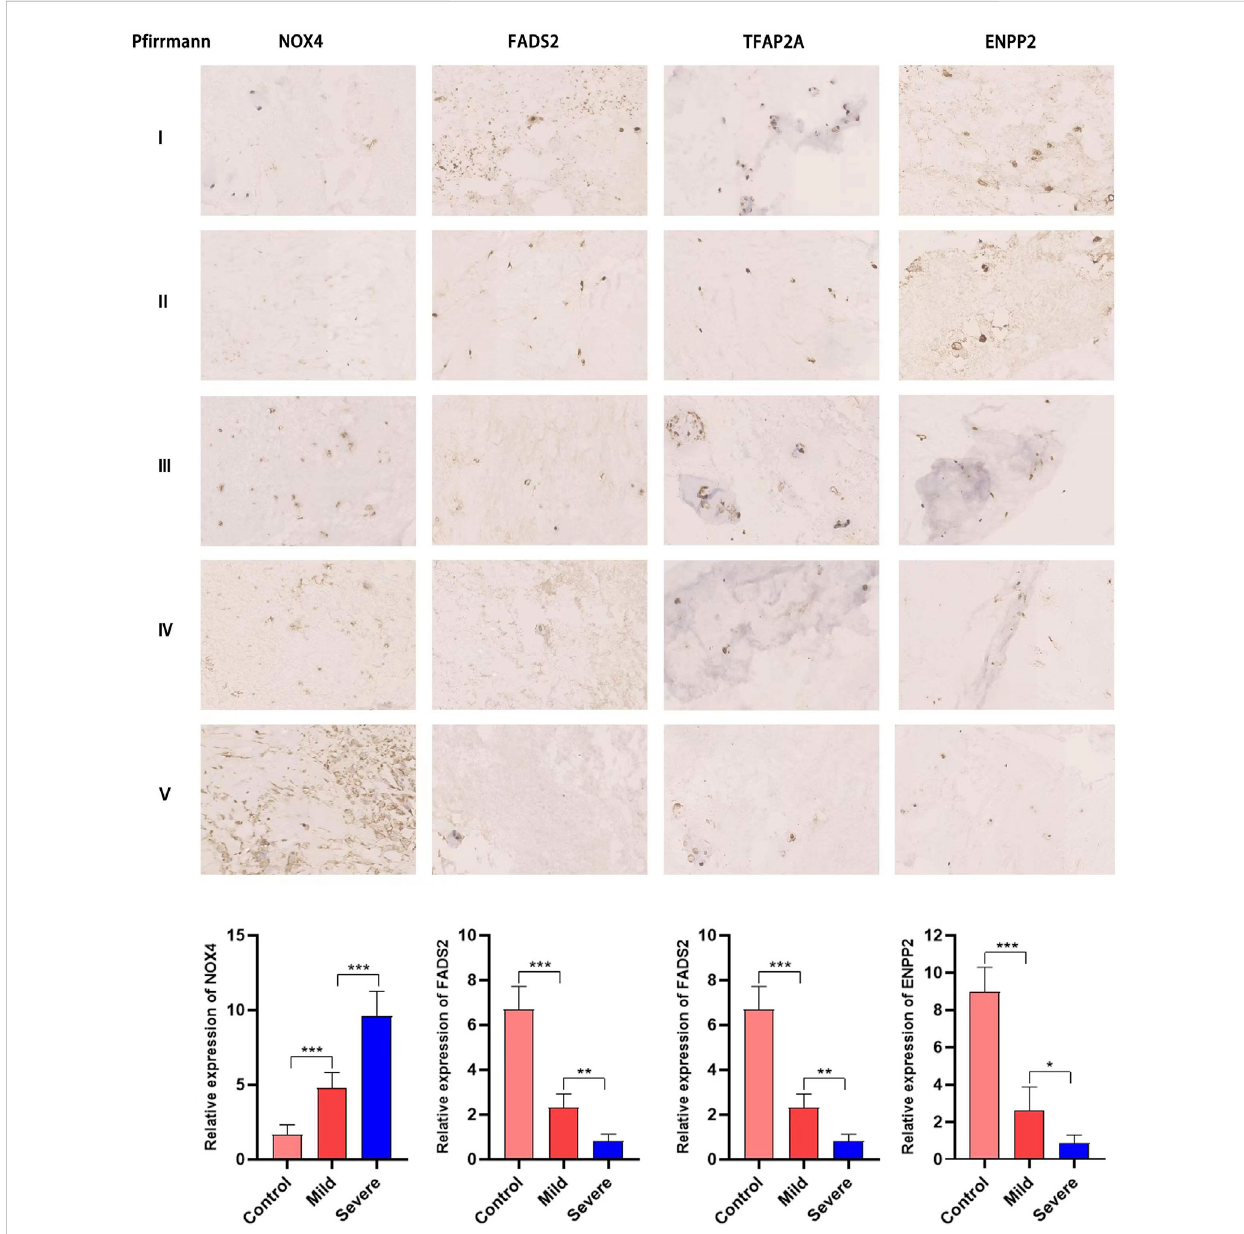
FIGURE 10 Immunohistochemical staining has proved that NOX4, FADS2, TFAP2A, ENPP2 expression in NP tissues of different degeneration grades. The expression ofNOX4 increases withtheincrease ofdegenerationgrade, whiletheexpressionofFADS2,TFAP2A,ENPP2 isgradually downregulated (*, p < 0.05; **, p <